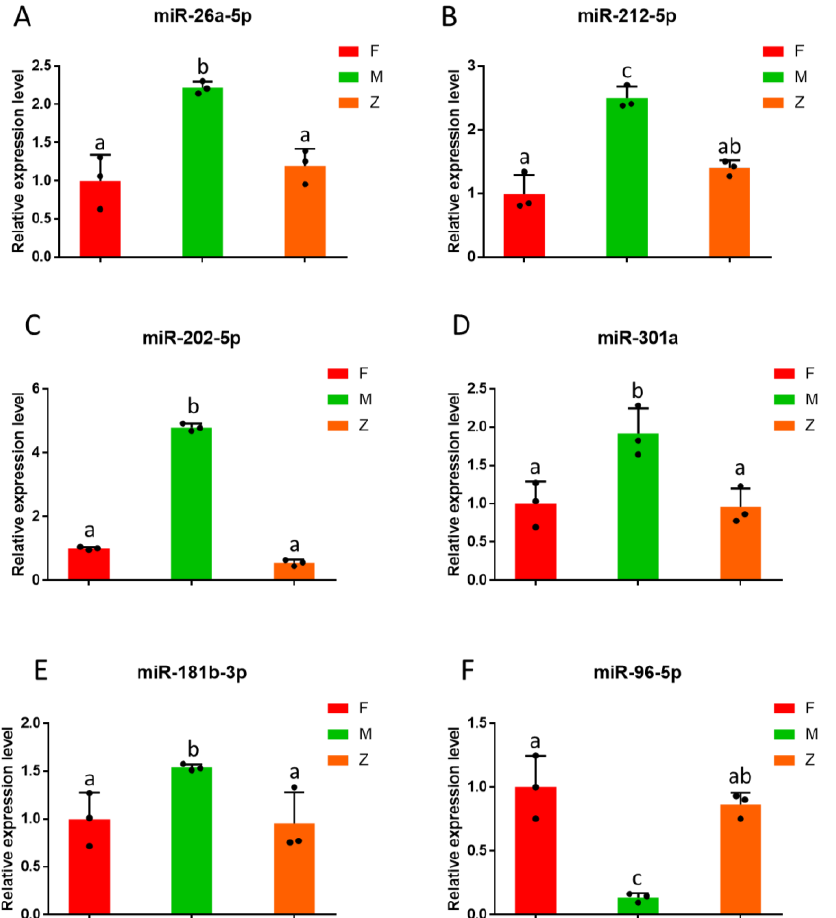
Figure 6. The relative expression level of differential miRNAs among males, females, and pseudo- females: ( A ) The relative expression level of miR-26a-5p among males, females, and pseudo-females. ( B ) The relative expression level of miR-212-5p among males, females, and pseudo-females. ( C ) The relative expression level of miR-202-5p among males, females, and pseudo-females. ( D ) The relative expression level of miR-301a among males, females, and pseudo-females. ( E ) The relative expression level of miR-181b-3p among males, females, and pseudo-females. ( F ) The relative expression level of miR-96-5p among males, females, and pseudo-females. Data were expressed as mean ± SD. Different letters show significant differences ( p < 0.5).